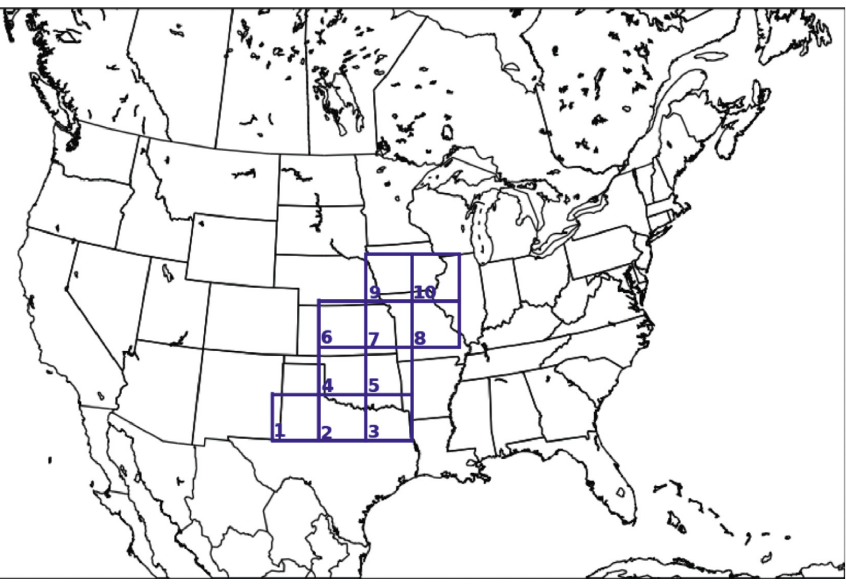
Figure 1: Members, numbered, of the wind farm location ensemble (in outlined boxes). Table 1: Cases used in the study, the type of cyclone observed in model simulation, and the location ensemble with the largest